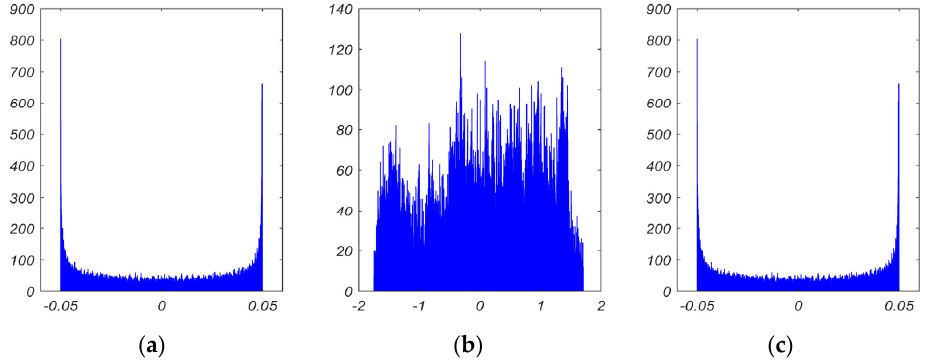
Figure 10. Histograms: ( a ) the original information signal; ( b ) the encrypted signal; ( c ) the retrieved signal.